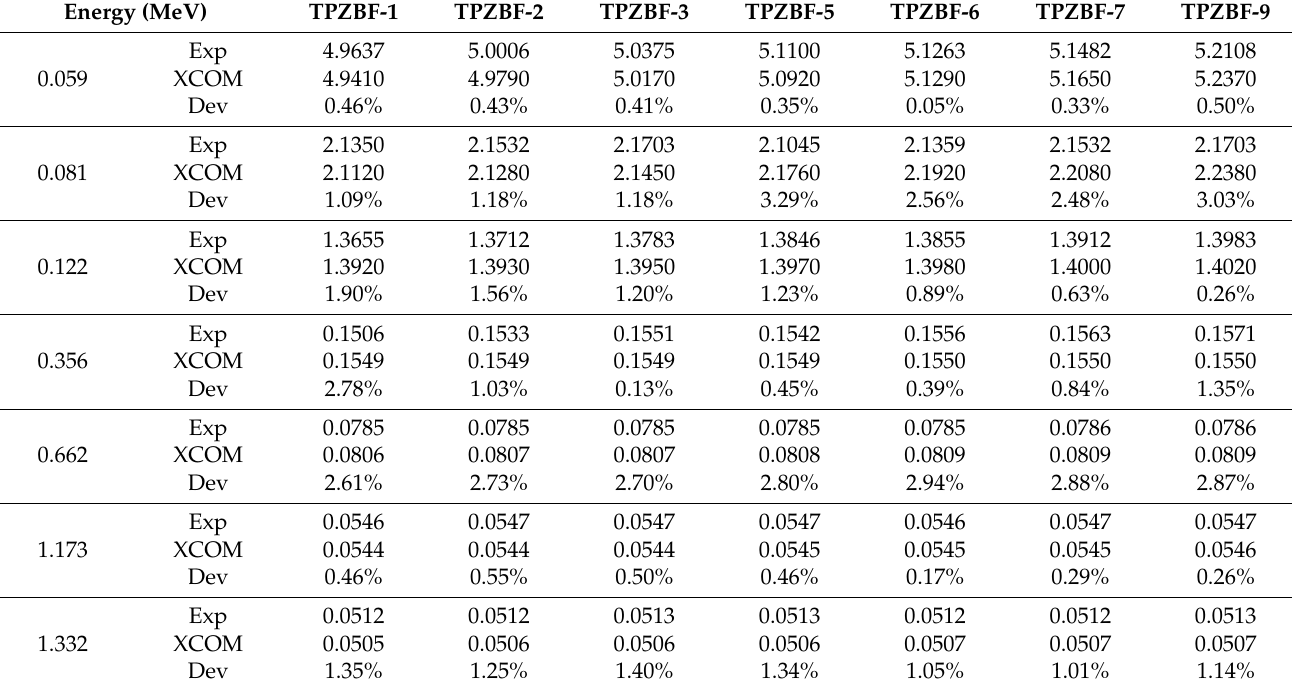
Table 2. Value and Dev of ( µ m ) Exp and ( µ m ) XCOM